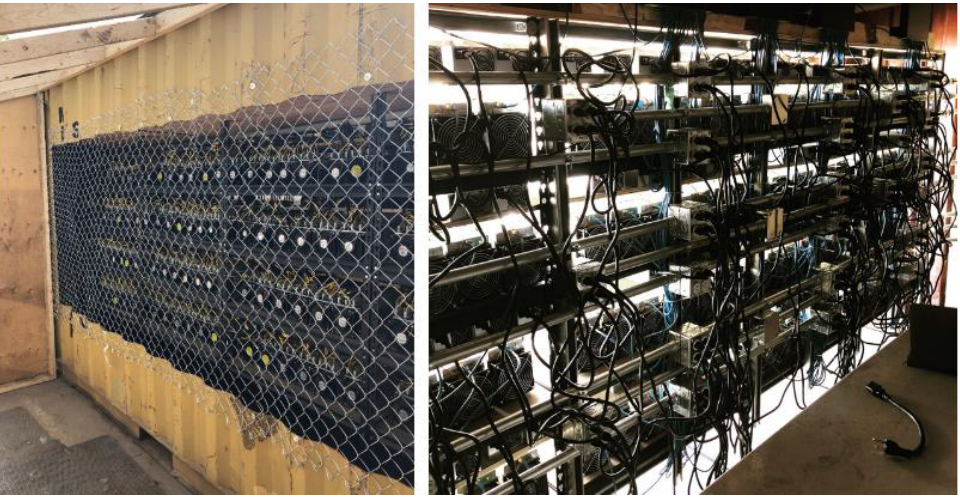
Figure 3. DIY cryptocurrency mining container supporting 50 Antminer S17es. External facing heat exhaust is shown on the left, and the internal mining components are shown on the right.